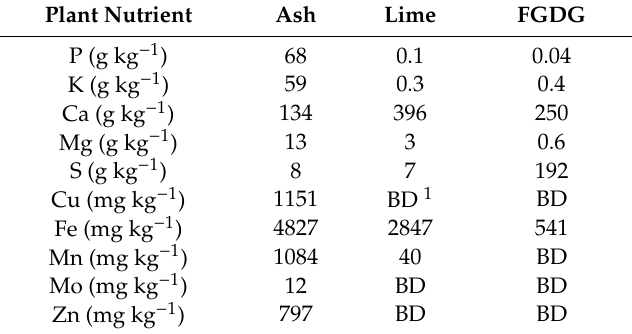
Table 2. Plant nutrient composition of the poultry litter ash, calcitic lime, flue gas desulfurization gypsum (FGDG) used in the greenhouse experiment. Plant Nutrient Ash Lime FGDG P (g kg − 1